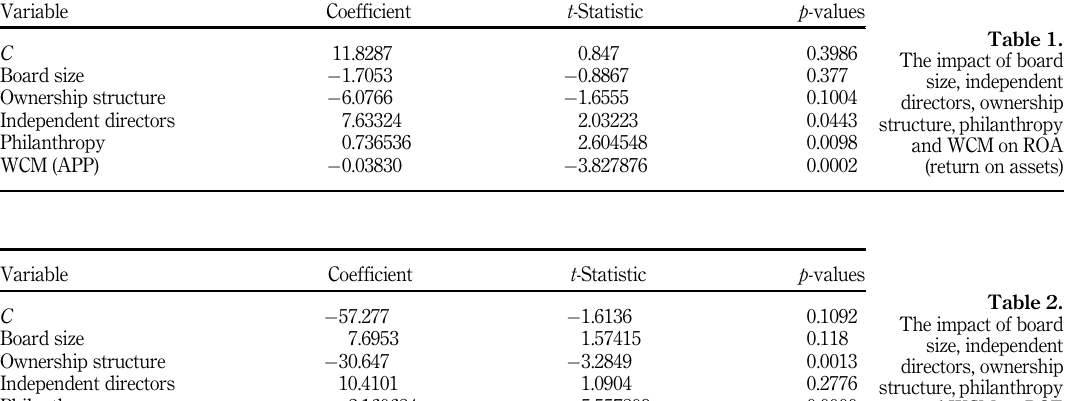
Table 1. The impact of board